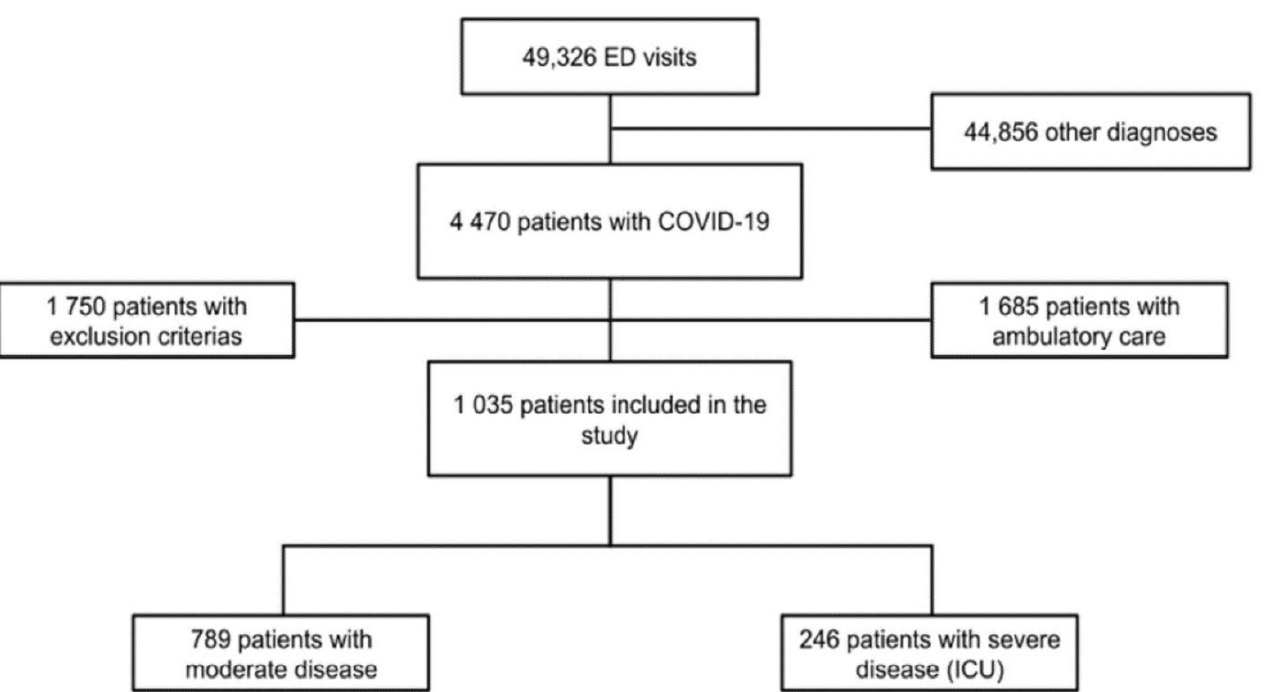
Figure 1. Flowchart of the study. Legend: ED: emergency department, ICU: intensive care unit, COVID-19: coronavirus disease.